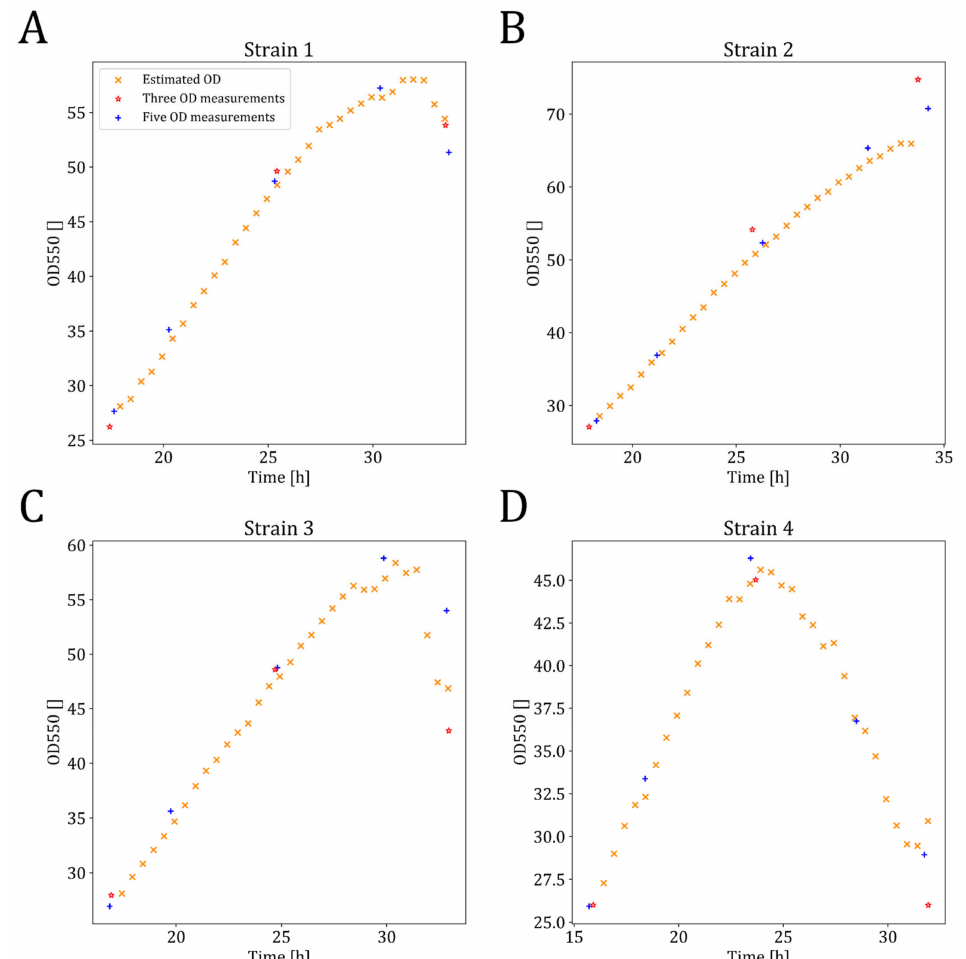
Figure 5. Simulations of the generalized OD soft sensor for fermentations during which three OD measurements were conducted. The measured ODs for specific experiments are shown together with the model estimates for that experiment and the average measured ODs of experiments with identical process parameter set points where five measurements were taken. One representative simulation is presented each for ( A ) strain 1, ( B ) strain 2, ( C ) strain 3 and ( D ) strain